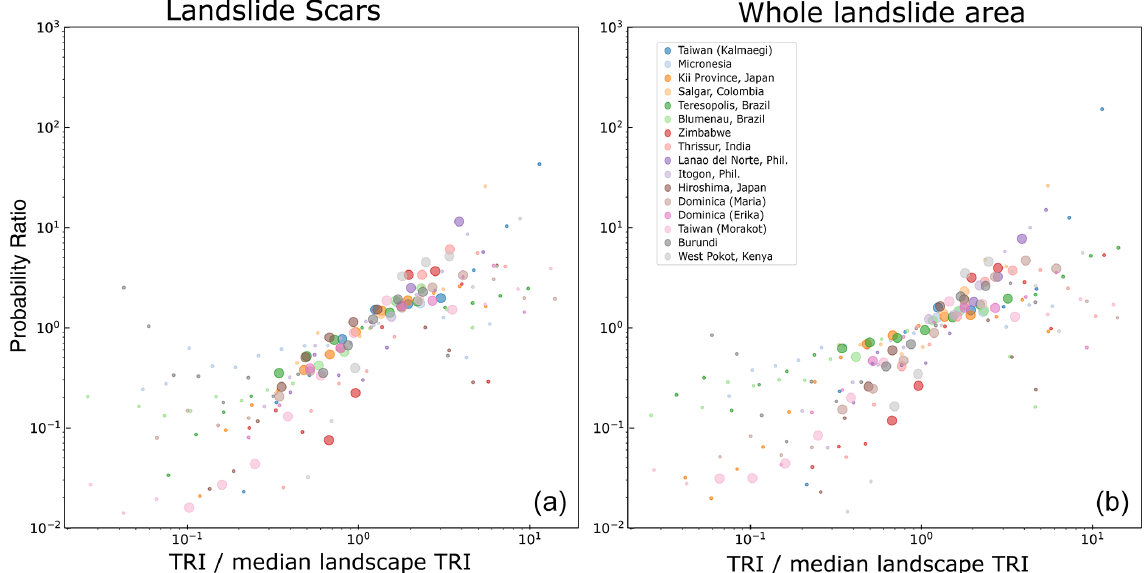
Figure 7. Same as Fig. 4 but for the topographic ruggedness index